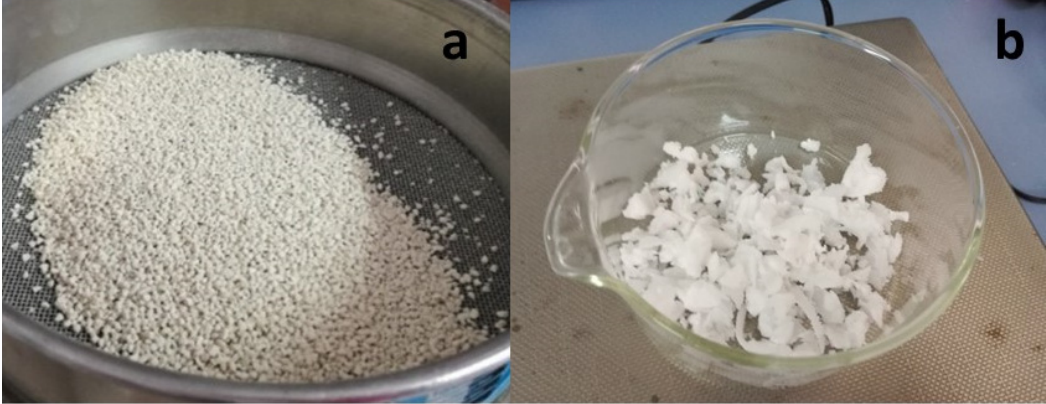
Figure 1. ( a ) Milled and sieved Lecce stone and ( b ) PEG 1000 in solid form.